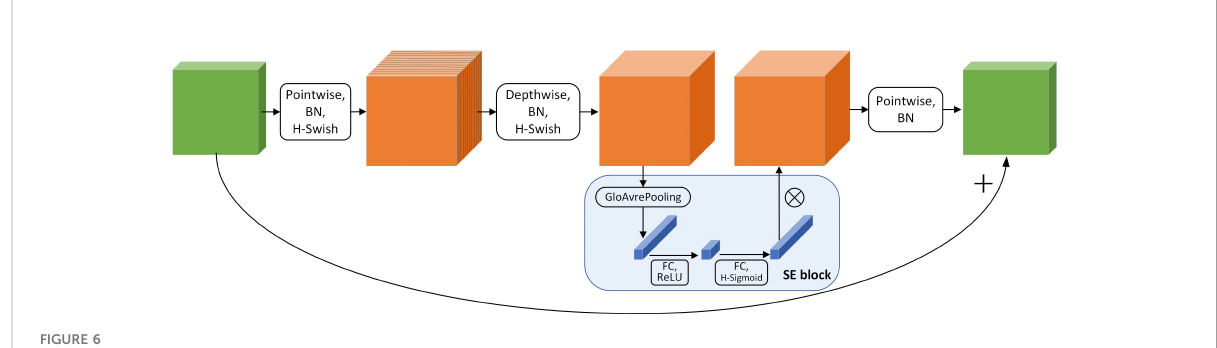
FIGURE 6 MobileNetV3 block